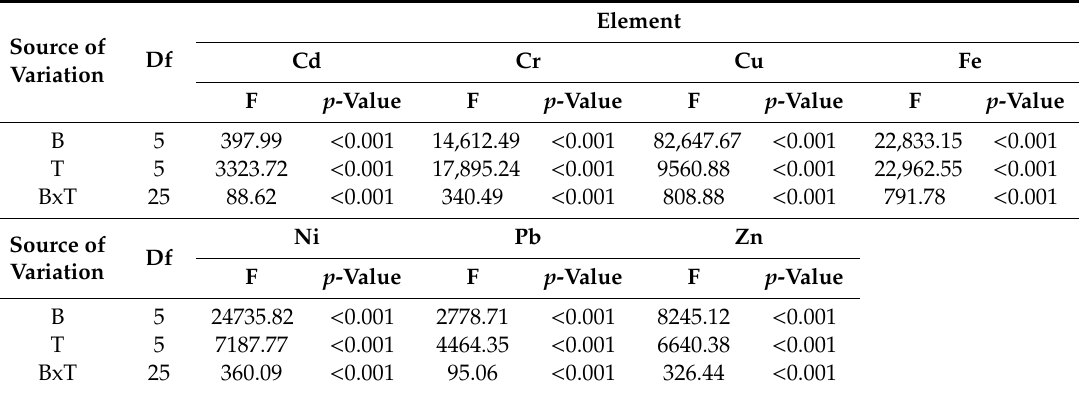
Table 1. Results of two-factor analysis of variance (two-way ANOVA) for biomass (B), temperature (T) and biomass and temperature interaction (BxT).